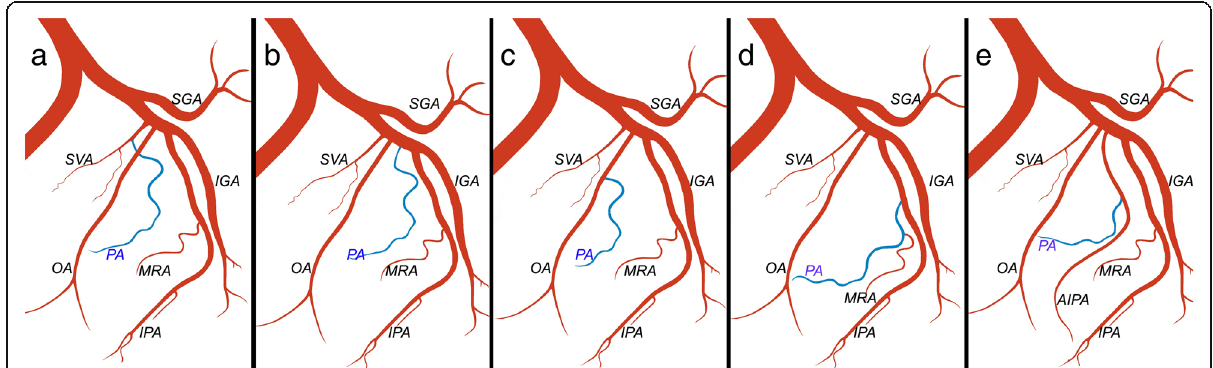
Fig. 1 Schematic diagram (ipsilateral oblique view) of the 5 types of prostatic artery (PA, in blue) origin according to de Assis and Carnevale (de Assis et al. 2015). a Type I, common origin of the SVA and PA. b Type II, PA origin from the anterior division of the internal iliac, independent from and inferior to the SVA. c : Type III, PA origin from OA. d Type IV, PA origin from IPA. e Type V, less common origins, the most frequent of which (presented here) is PA origin from AIPASVA-superior vesical artery, OA-obturator artery, MRA-middle rectal artery, IPA-internal pudendal artery, AIPA-accessory internal pudendal artery, IGA-inferior gluteal artery, SGA-superior gluteal